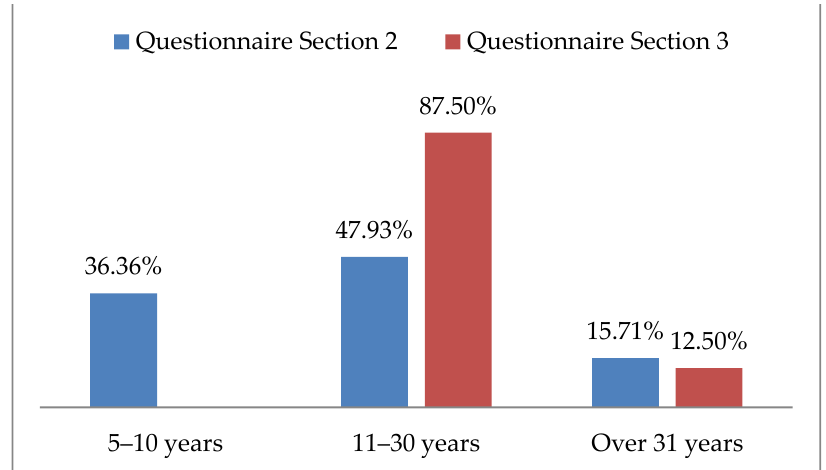
Figure 5. Processed results of Section 1 of the questio nnaire. The question “Identification of in- volvement of experts in the construction process”.